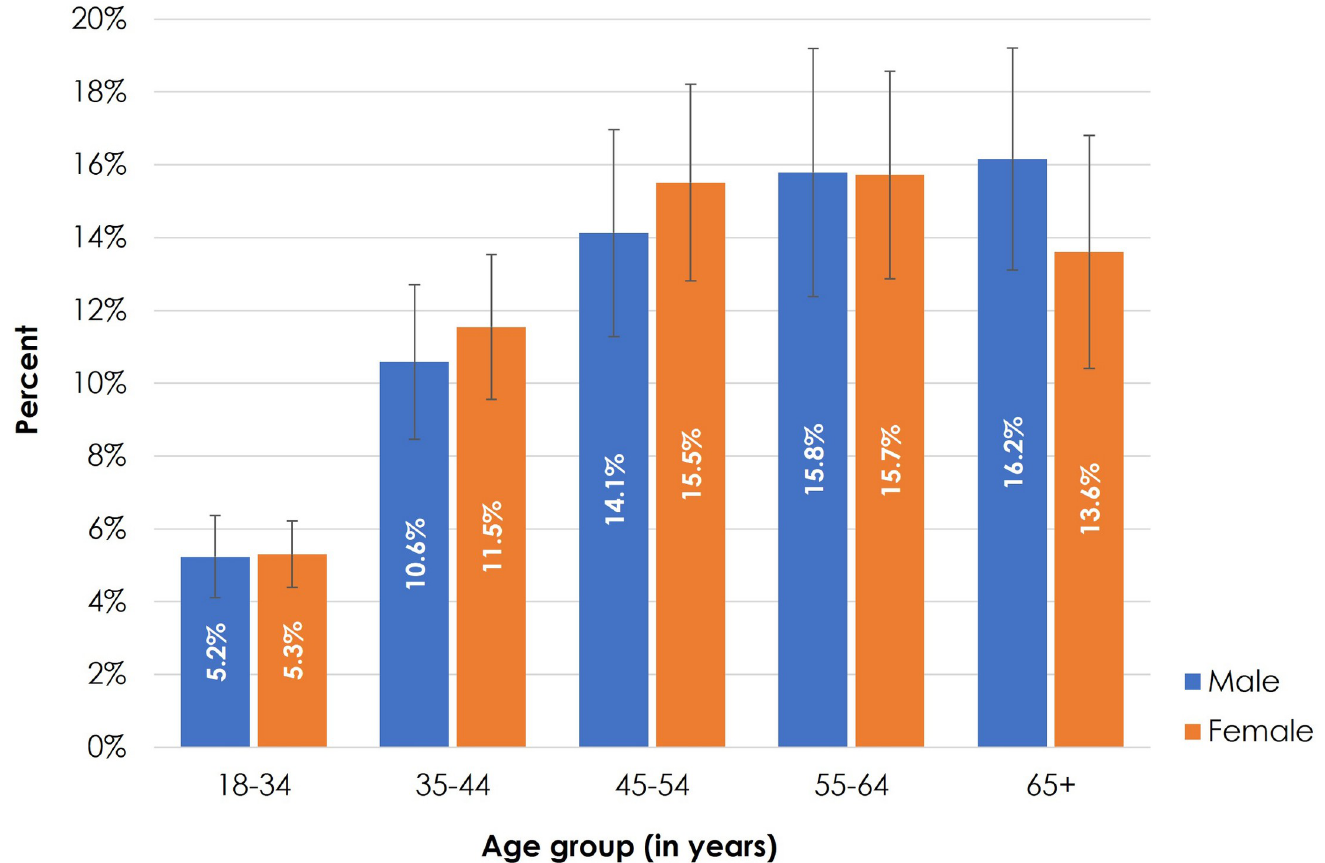
Fig 1. Prevalence of diabetes by age group and sex in Bangladesh, 2017–18.